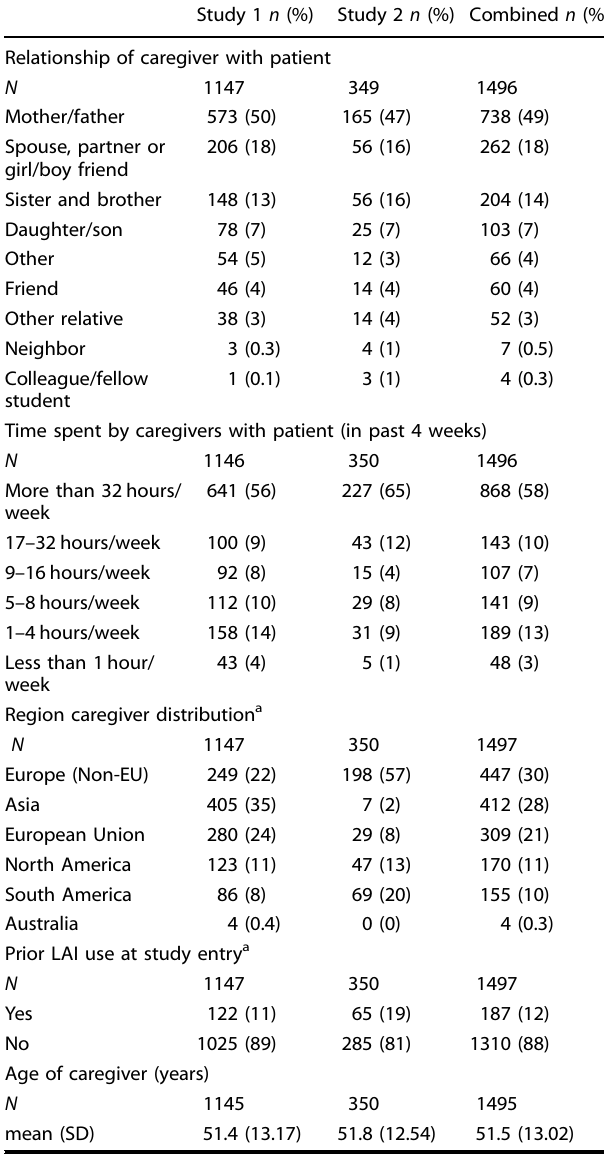
Table 1. Demographics and baseline characteristics